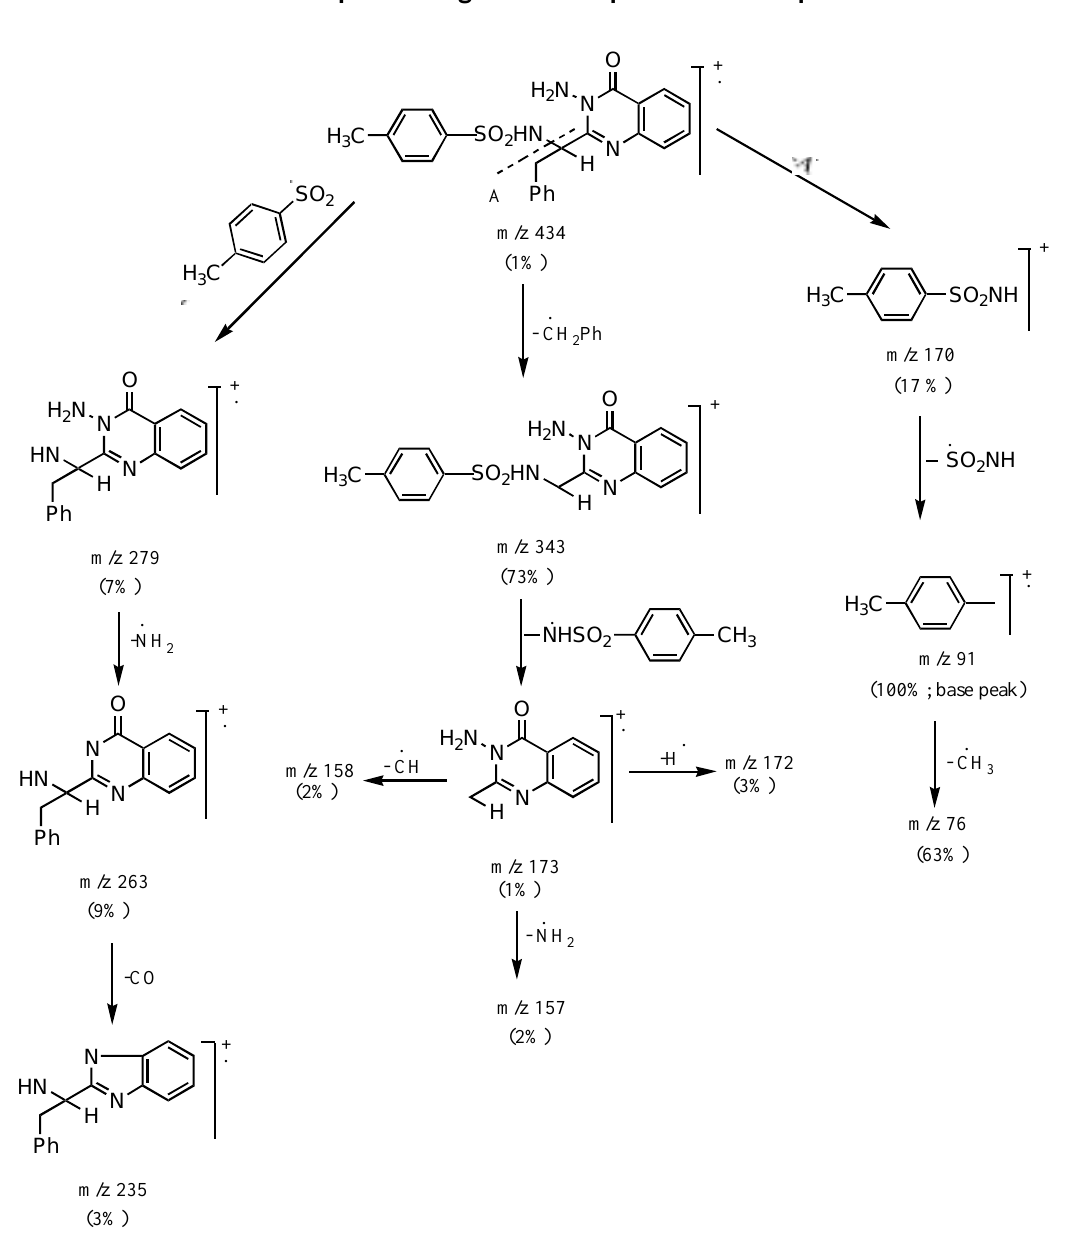
Scheme 2: Proposed fragmentation pattern of compound